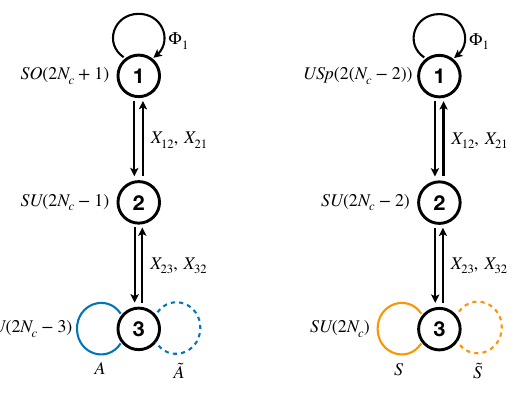
Figure 11 . N = 1 S-dual quiver diagrams with n g = 2 .